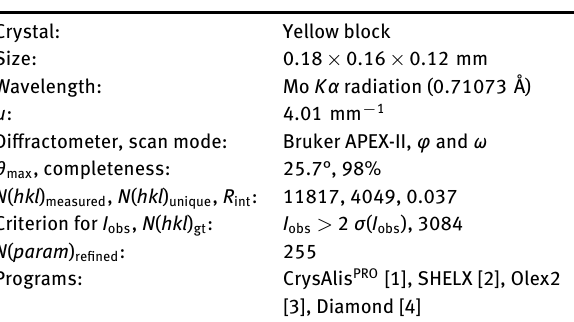
Table 1: Data collection and handling.